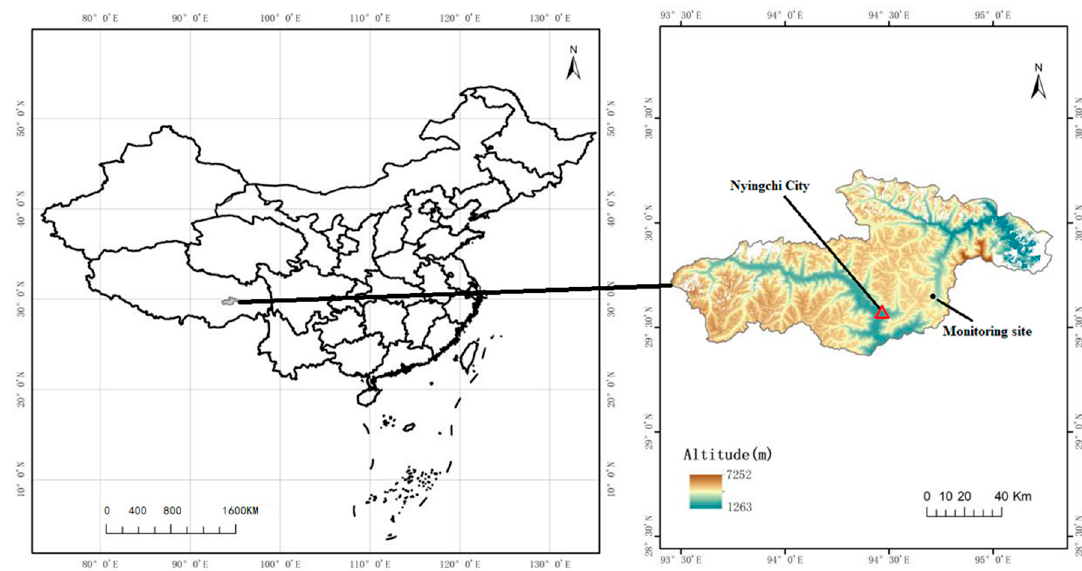
Figure 1. Location of the Nyingchi City and nitrogen deposition monitoring site.